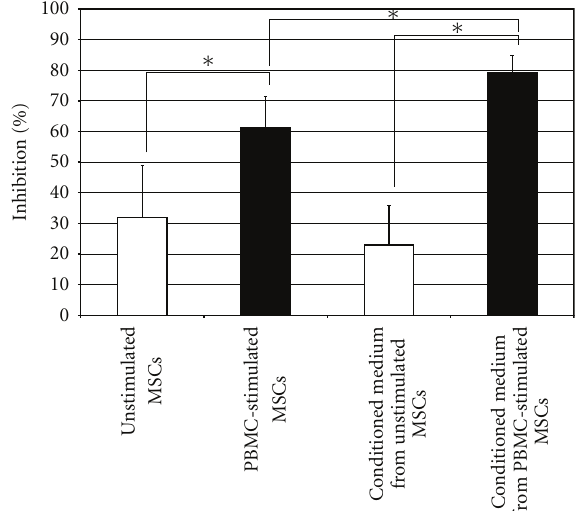
Figure 3: Immunosuppressive activity of hMSC-conditioned medium. Immunosuppressive activity of unstimulated (white bars) and PBMC-stimulated (black bars) hMSCs and hMSC-conditioned media. Values are expressed as percent inhibition relative to PHA- stimulated PBMCs which served as controls. Higher bars indicate more immunosuppressive activity. Asterisks indicate significant di ff erences in one-tail t -test; ∗ P < .